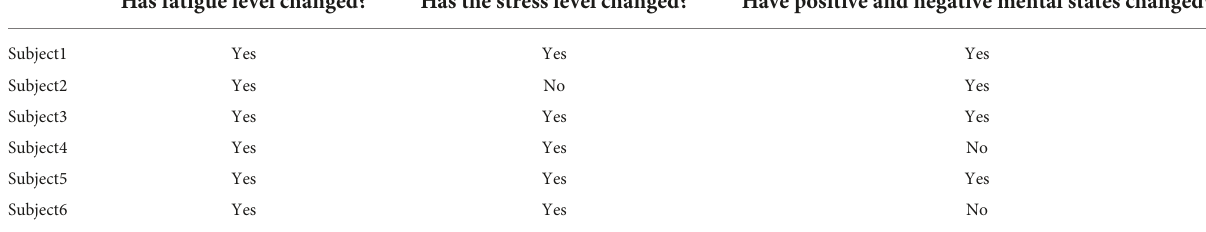
TABLE 1 Subjective evaluation results of mental state during the experiment. Has fatigue level changed? Has the stress level changed? Have positive and negative mental states